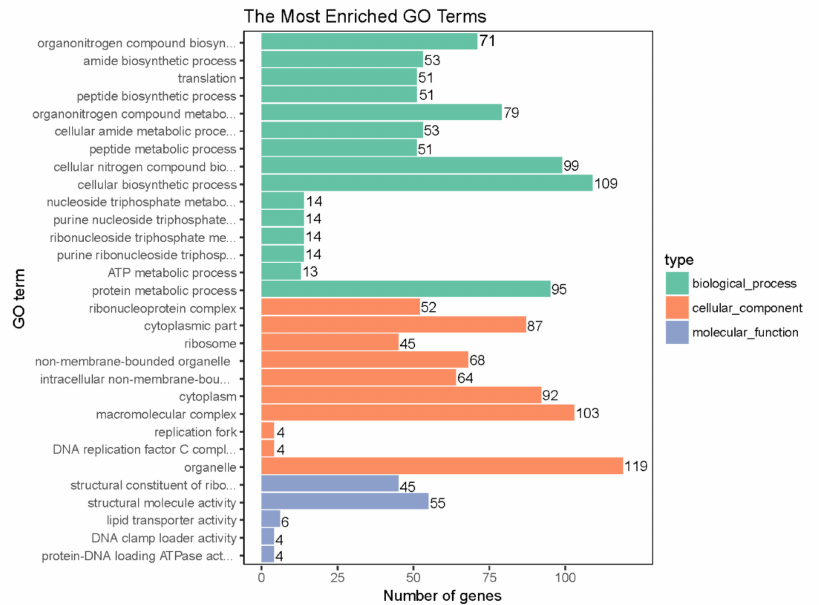
Figure 5. Highly expressed GO enrichment of coral. The green, orange and gray bars represent the biological process, molecular function and cellular component, respectively. The horizontal axis shows the number of genes and the vertical axis the GO term.